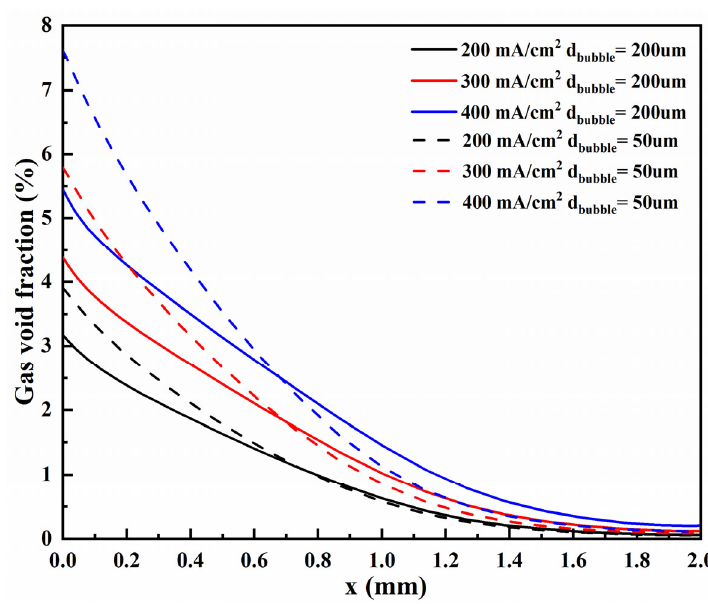
Figure 5. Gas void fraction curves of these two bubble diameters at the top of the H 2 compartment under different current densities.